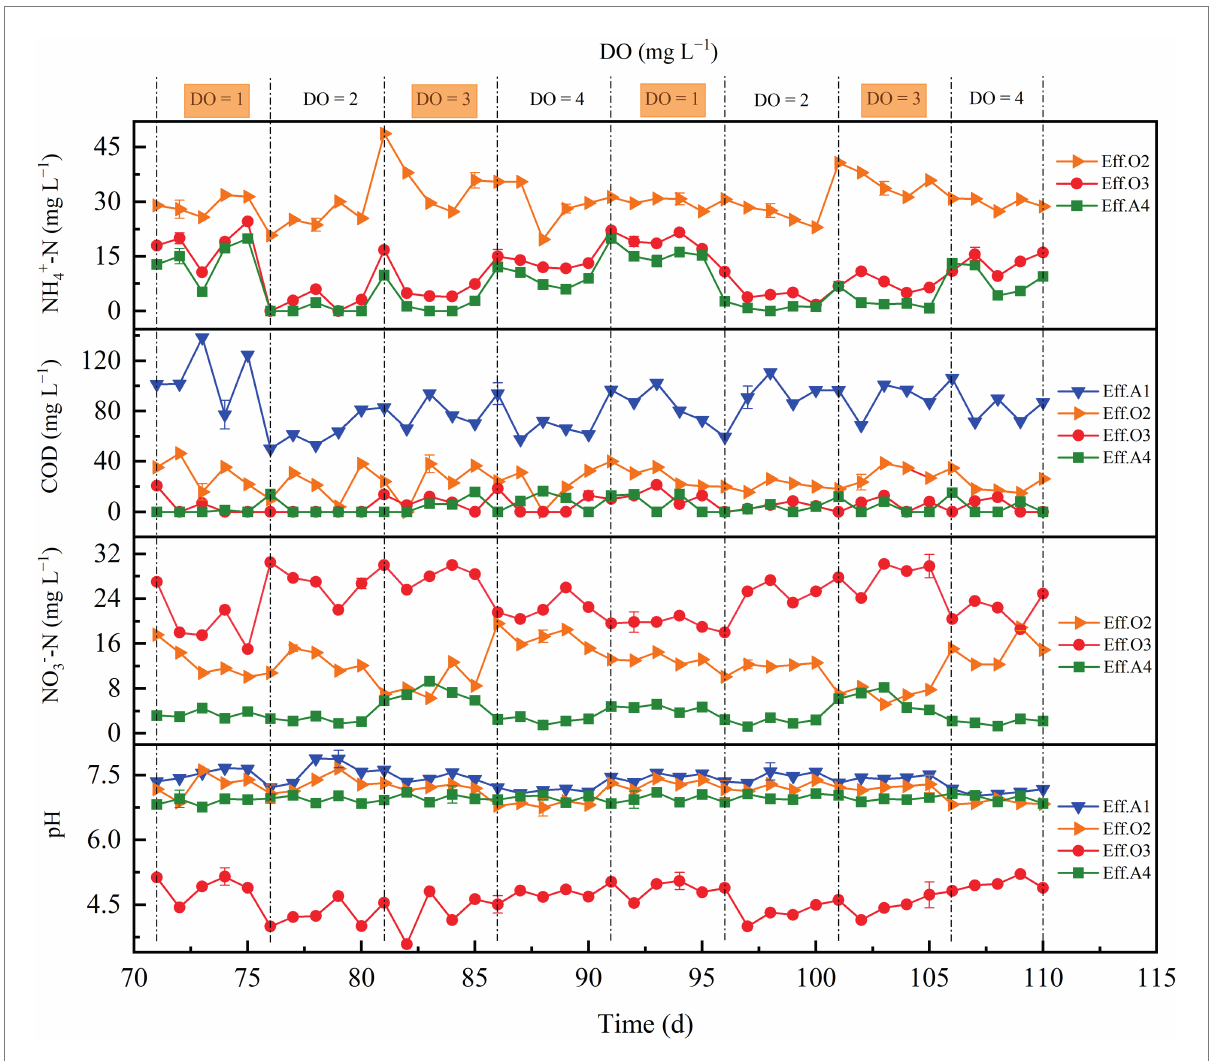
FIGURE 2 Performance of the reactor during period